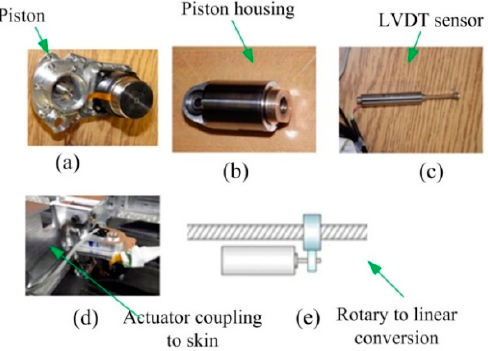
Figure 5. The morphing actuator: ( a ) piston, ( b ) piston housing, ( c ) LVDT sensor, ( d ) actuator coupling with wing skin, and ( e ) principle of rotary to linear conversion.